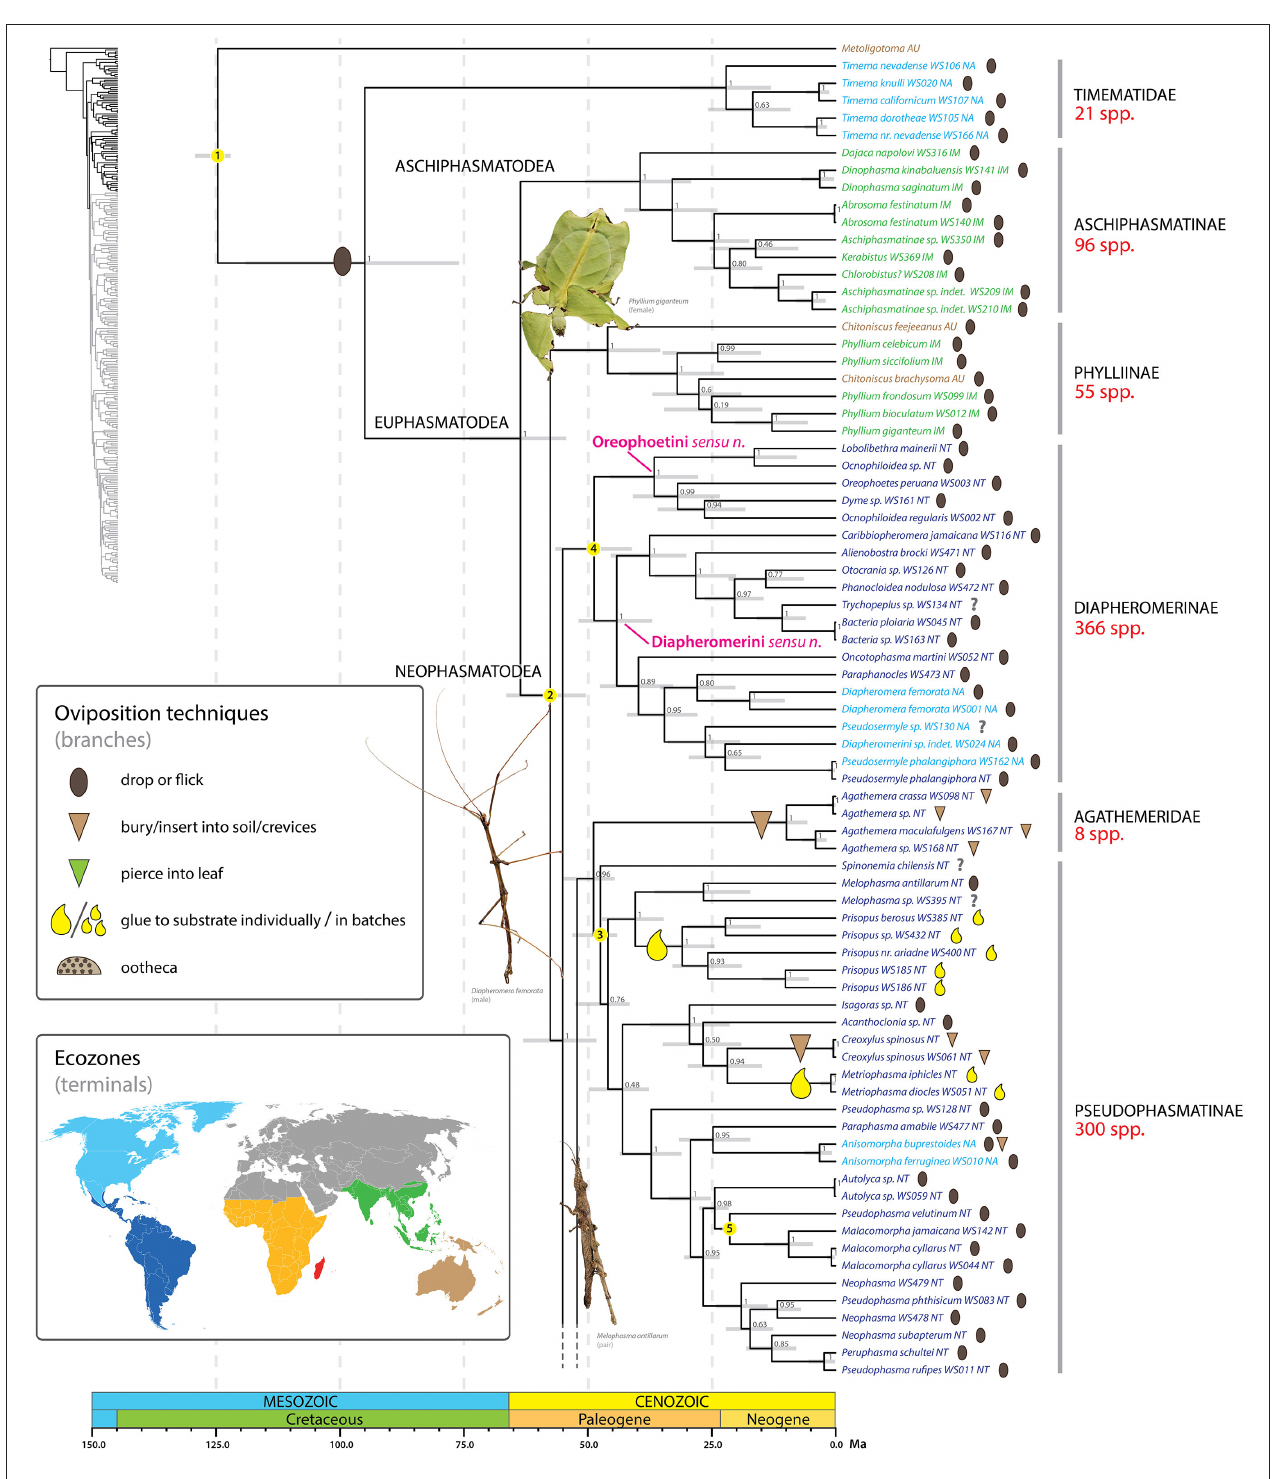
FIGURE 4 | Chronogram of Phasmatodea (part 1 of 3). The full time tree is shown to the left with the emboldened region enlarged and colored for discussion. Fossil calibration points are denoted with numbered yellow circles (see Supplementary Table S2 ). Ninety-five percentage confidence intervals around node ages are indicated by gray bars. Bayesian posterior probability confidence intervals are listed for each node. Terminals are colored by ecozone following the inset. Oviposition technique for each sampled species is shown to the right of the terminal according to the inset, with inferred transitions optimized and marked on the branches. Photos of stick and leaf insects by Melinda Fawver ( Diapheromera femorata ), Isselee ( Phyllium giganteum ), Bruno Kneubühler ( Melophasma antillarum ) modified for use, used by permission.